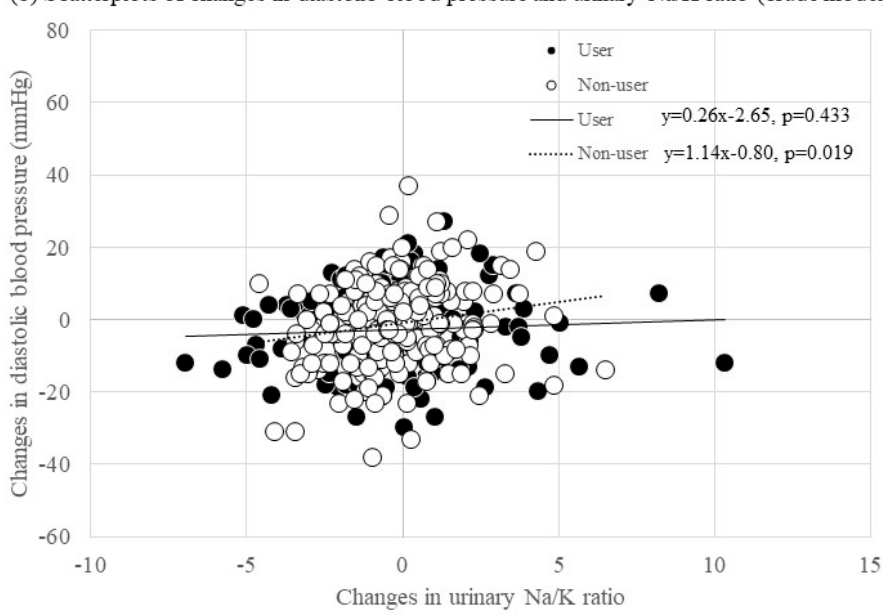
Figure 2. Scatterplots of changes in blood pressure and the urinary Na/K ratio by using antihyper- tensive tensive medication